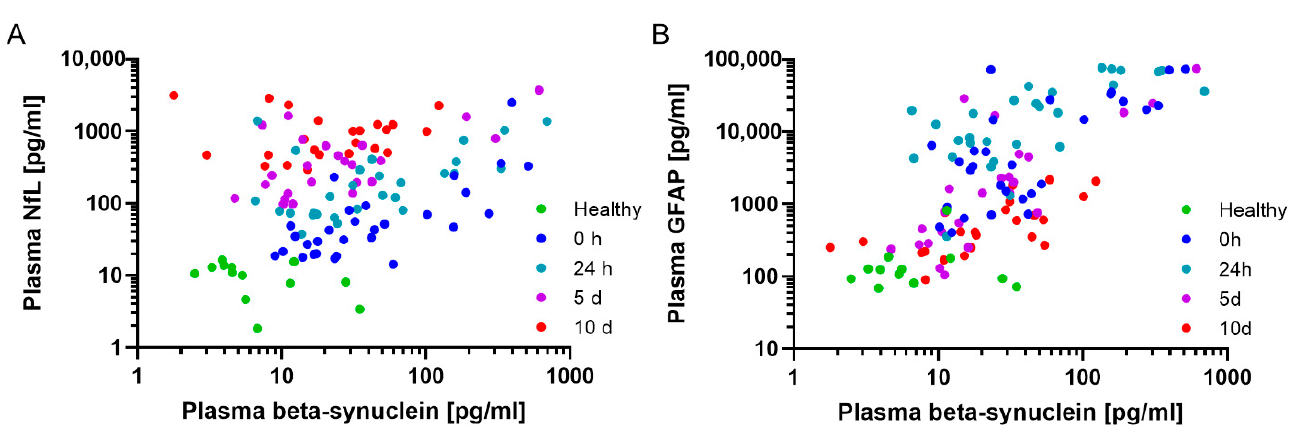
Figure 1. Systemic marker concentrations in the time course after severe injury. ( A – C ) Plasma NfL ( A ), beta-synuclein ( B ), and GFAP ( C ) concentrations in the time course after severe trauma compared to levels in healthy volunteers. Scatter plots are displayed for the individual sampling dates. The mean concentrations + SD are illustrated in ( A – C ). Groups were compared by Kruskal– Wallis test and Dunn’s post hoc test. **** p < 0.0001, ** p < 0.01, * p < 0.05 vs. healthy volunteers. ( D ) Time course of the observed marker concentrations in polytraumatized patients and healthy volunteers; since plasma concentrations differed by two decimal potencies, units were adjusted to align time courses in one graph; please see legend for respective units. Data are shown as means (solid lines) ± SEM (shaded zones). N = 13 (healthy), n = 29 (0 h), n = 28 (24 h), n = 24 (5 d), n = 23 (10 d) for ( A – D ). GFAP,